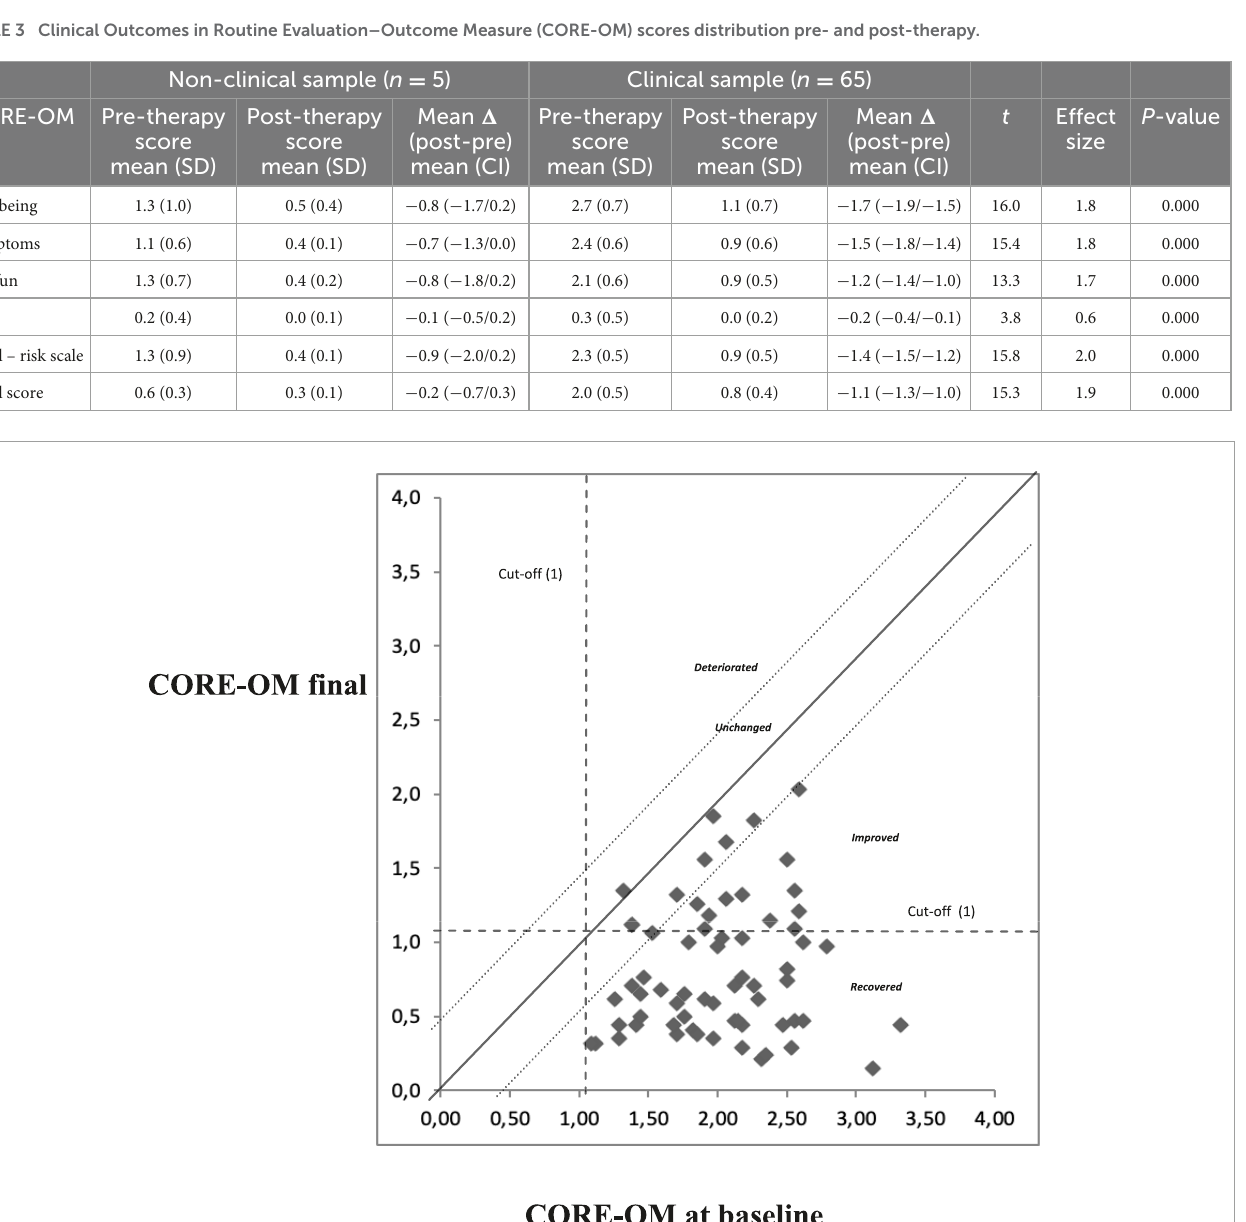
FIGURE1 Graphical representation of changes in Clinical Outcomes in Routine Evaluation–Outcome Measure (CORE-OM) total score between baseline and end of